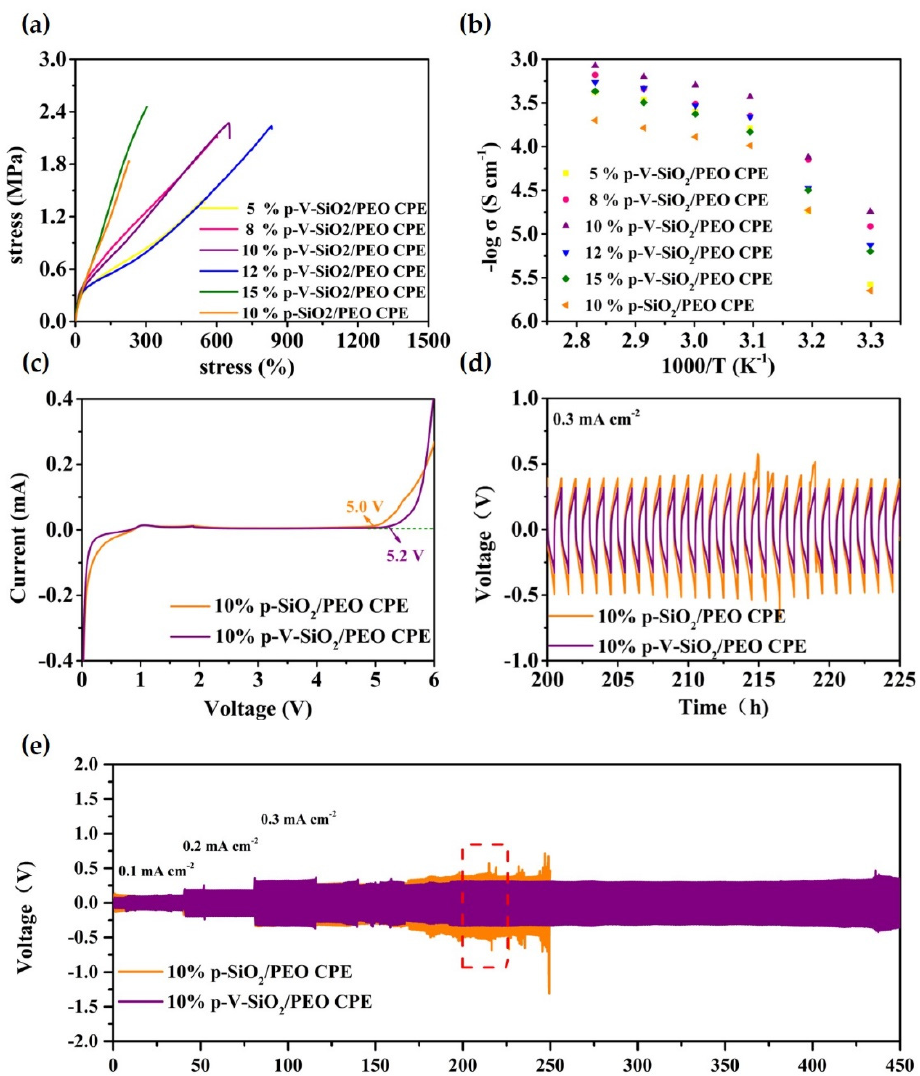
Figure 5. ( a ) Stress − strain curves of CPEs with di ff erent mass ratios of p-V-SiO 2 (or p-SiO 2 ). ( b ) EIS profiles of CPEs with different mass ratios of p-V-SiO 2 (or p-SiO 2 ) at the range of 30 − 80 °C . ( c ) LSV curves of 10% p-V-SiO 2 /PEO CPE and 10% p-V-SiO 2 /PEO CPE membranes at 60 °C. ( d ) The enlarged time–voltage profiles from 200th to 225th h. ( e ) The time–voltage profiles of Li|10% p-V-SiO 2 /PEO CPE|Li and Li|10% p-SiO 2 /PEO CPE|Li symmetrical cells at 60 °C.